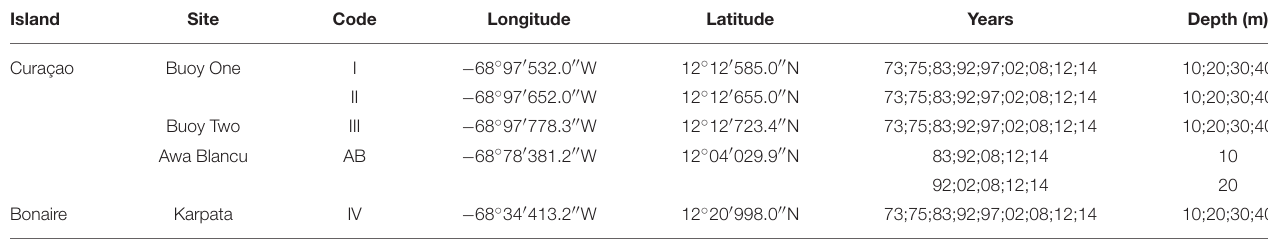
TABLE 1 | Survey site